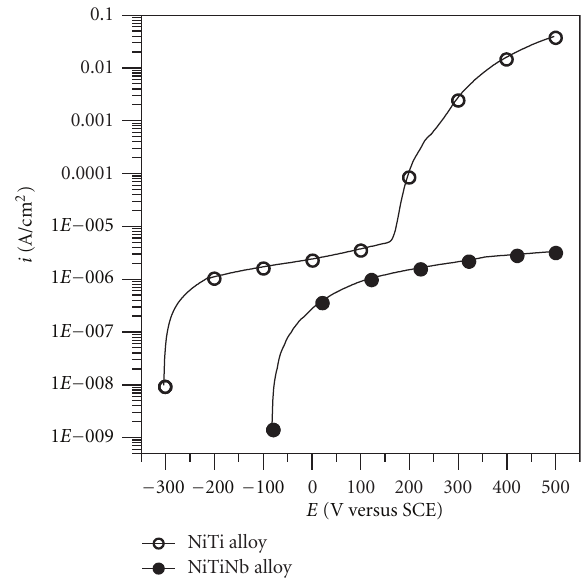
F 1: Linear anodic potentiodynamic polarization curves mea- sured for NiTi and NiTiNb alloys aer immersion in physiological 0.9wt NaCl %